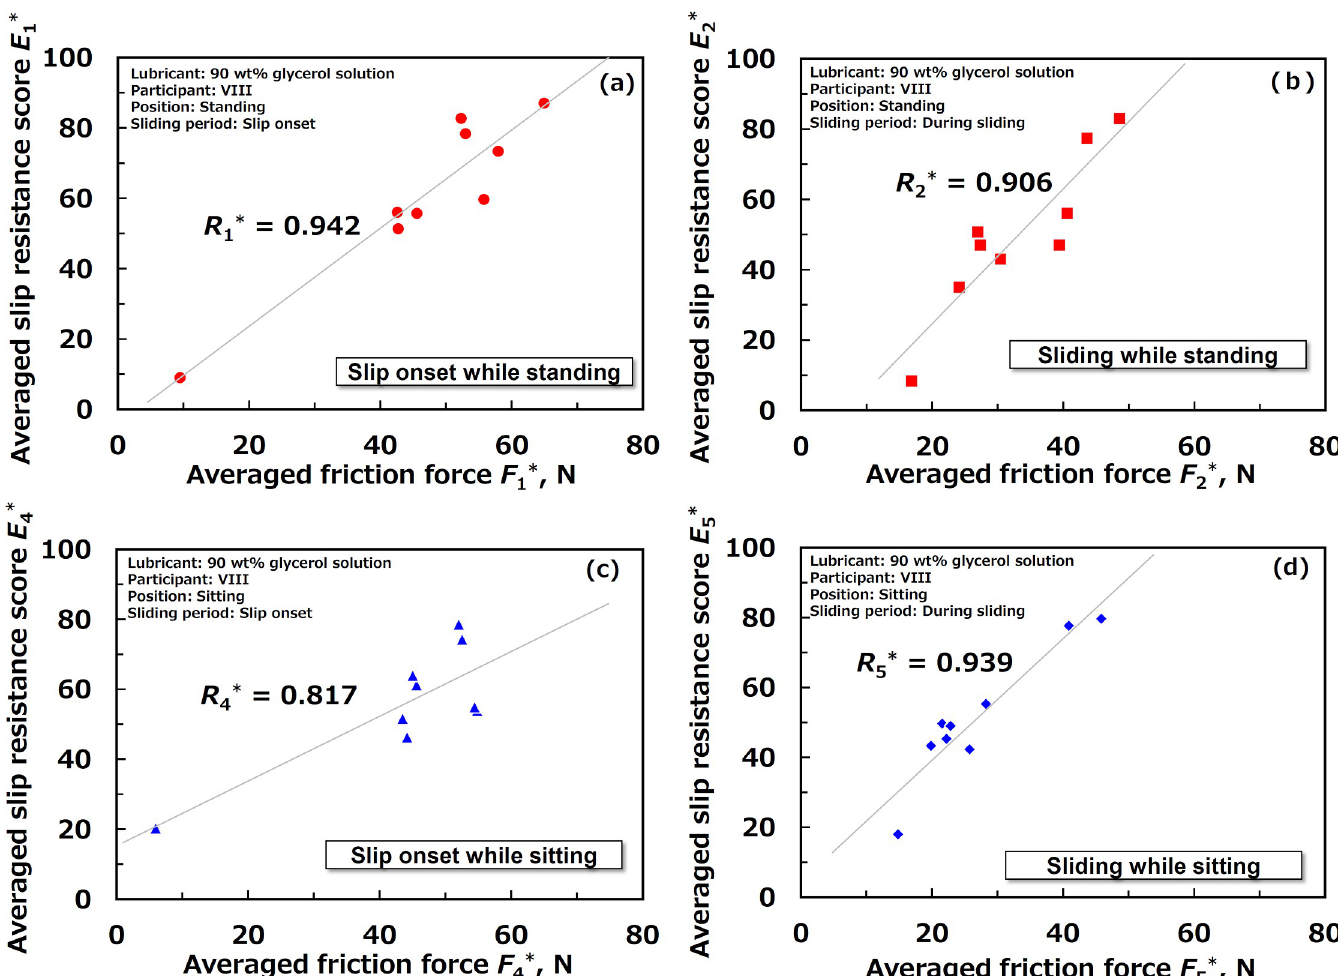
Fig 6. Relationship between friction forces and slip-resistance scores after averaging for participant VIII (a) at slip onset while standing, (b) during sliding while standing, (c) slip onset while sitting, and (d) during sliding while sitting.